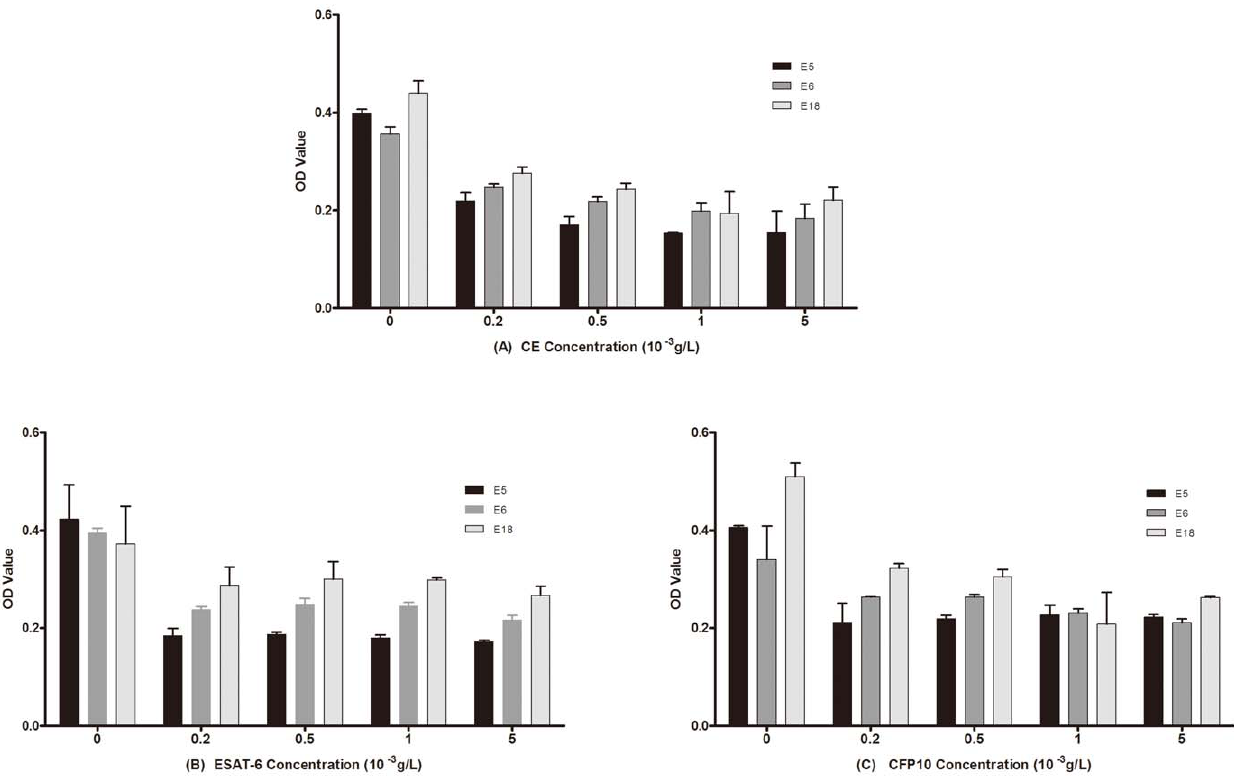
Figure 6. Competitive inhibitions of E5BIO, E6BIO and E18BIO peptides binding to anti-CE pAbs with CE(A), ESAT-6(B) and CFP10(C) proteins, respectively. Equal volume individual biotin-labeled peptides and CE, EAST-6 or CFP10 protein with different concentrations (0 g/L, 0.2 6 10 2 3 g/L, 0.5 6 10 2 3 g/L,1 6 10 2 3 g/L, and 5 6 10 2 3 g/L) were mixed and added to the plates coated with anti-CE pAbs. Streptavidin conjugated to horseradish peroxidase was used to detect the peptides. ELISA was performed continuingly as described before. Absorbance values of the 3 peptides binding to anti-CE pAbs were all decreased with the adding of any one of the 3 proteins. doi:10.1371/journal.pone.0052848.g006 those of healthy individuals (t= 4.086, P , 0.0001). Similar results were found for CE protein (t= 3.359, P= 0.0011) (Figure 8). Using a cut-off value at mean + 2SD of the healthy controls values, the sensitivity and specificity of E5 peptide were 54.5% and 91.7%, and for the CE protein were 34.1% and 97.9%, respectively. The